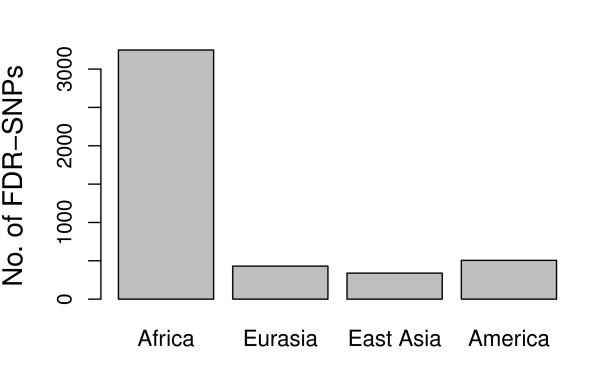
Continental groups showing the largest degree of genetic differentiation. For each FDR-SNP, we determined the allele frequency difference between populations in each continental group (Africa, Eurasia, East-Asia and America) and the rest of the world, and we assigned it to the continental group that showed the highest frequency difference. The histogram reports the number of FDR-SNPs in HDIs assigned to each group.